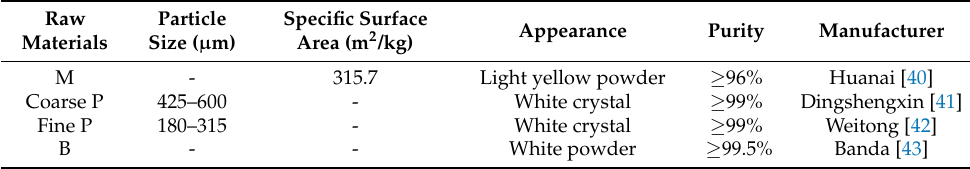
Table 2. Physical properties of M, P, and B.